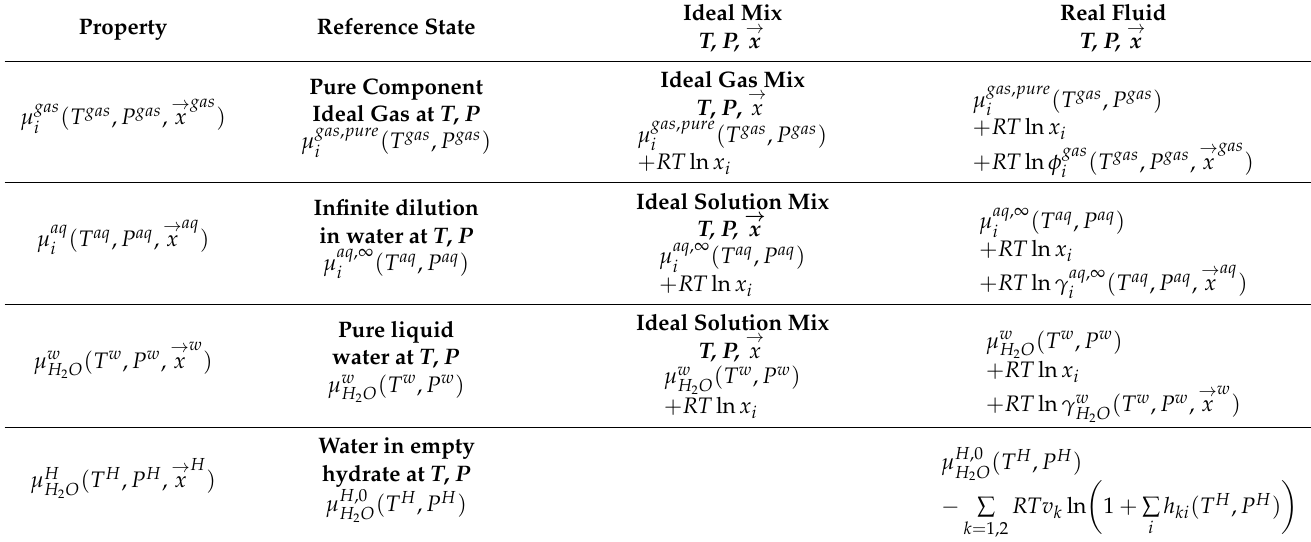
Table 1. Residual thermodynamic integration scheme for chemical potentials. Superscript gas denotes a separate guest phase (gas, liquid, super-critical). Superscript aq for guest molecule type i denotes guest molecules dissolved in water. The reference state here is infinite dilution of the component in water as indicated on chemical potential as well as on activity coefficient γ aq , convention). Superscript w denotes water phase (liquid water in this case). γ w convention, and a simple model for water activity coefficient as function of NaCl concentration in water is given in Appendix A. Superscript H denotes hydrate. The chemical potential for pure component ideal gas is trivially derived from the ideal gas canonical partition function. The CH 4 model utilized in our study is a spherical mono-atomic model, and the integration of the translational Boltzmann factor is trivial and can be found in any textbook on physical chemistry. The same is true for the additional rotational contribution for the linear models of CO 2 utilized. For ideal gas water, the moments of inertia needed for the rotational part are from the TIP4P [33] model, as used by Kvamme and Tanaka [34]. The fugacity coefficients are calculated from the SRK [27] equation of